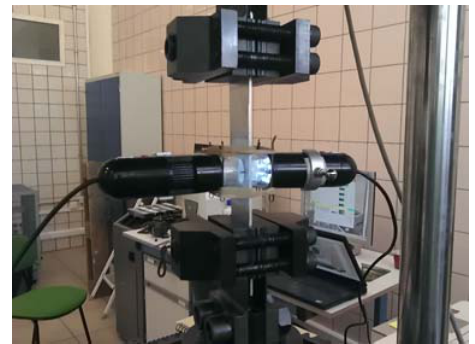
Figure 5: Microscopes attached to the specimen